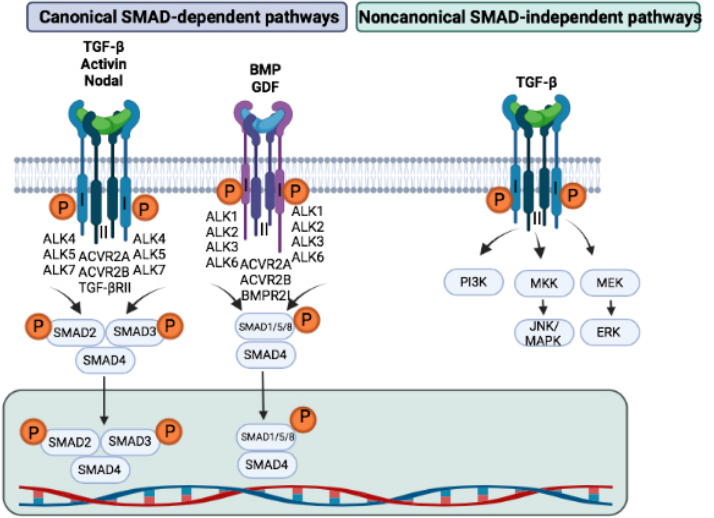
Figure 1. TGF- β superfamily signaling pathways. TGF- β superfamily proteins exert their cellular activity via canonical and noncanonical TGF- β signaling pathways. The activation of the heterote- trameric complex of TGF- β type I and type II receptors leads to phosphorylation and activation of SMAD proteins. In addition, TGF- β superfamily ligands can also activate noncanonical signaling pathways, such as the phosphatidylinositol 3-kinase (PI3K)/AKT, extracellular signal-regulated kinases (ERK), Jun N-terminal kinase family (JNK), and mitogen-activated protein kinase (MAPK) signaling